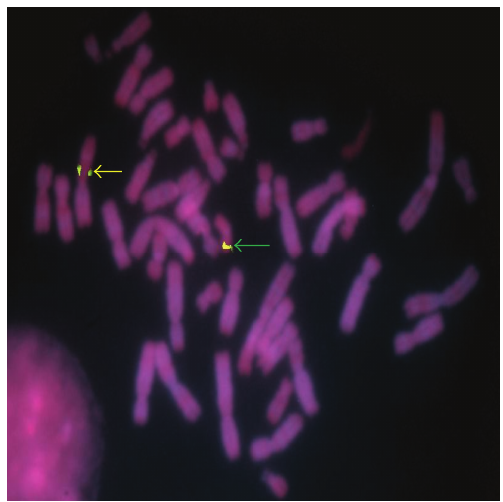
Figure 3: FISH with BAC clone RP11-878J15 on lymphocyte metaphase spreads of the patient. The signals in green (FITC) are shown by green arrow on normal 19 chromosome and the signals with yellow arrow points the derivative chromosome 14 on 19p13.3